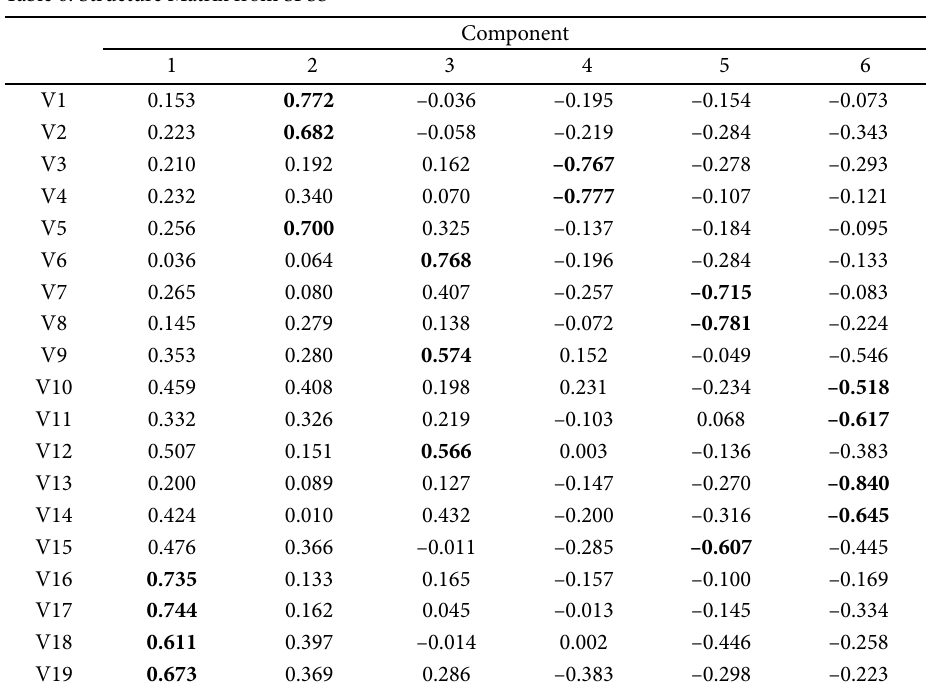
Table 6. Structure Matrix from